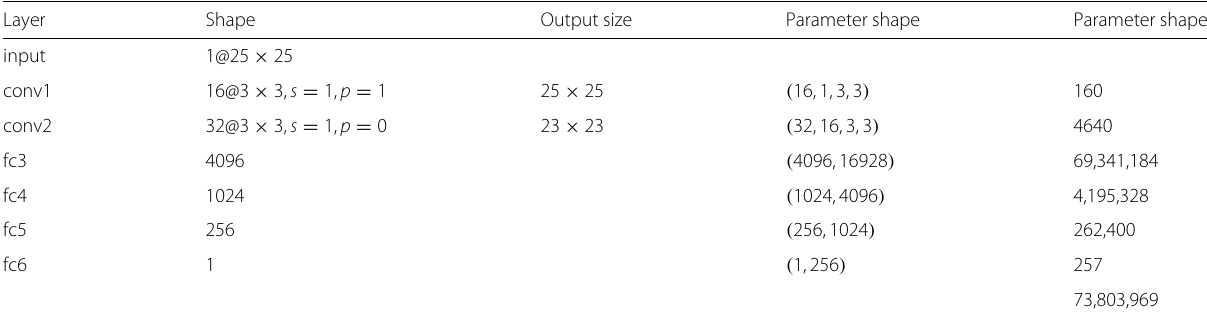
Table 3 Details of PERCNN